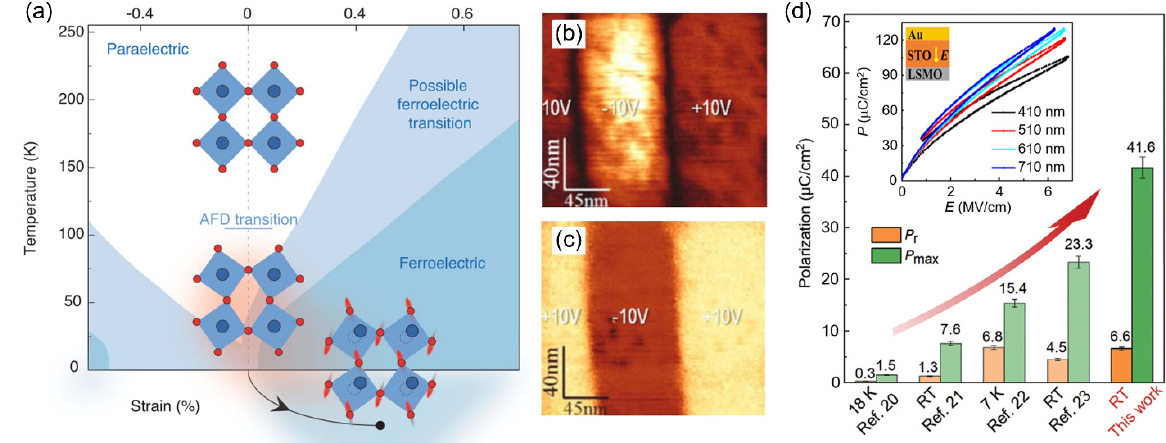
Figure 4. Structural phase transition and FE properties of SrTiO 3 . ( a ) Temperature–strain phase diagram showing an AFD transition and a further FE transition [102]. ( b,c ) Piezoresponse force microscopy (PFM) amplitude and phase images of strain-free SrTiO 3 films recorded at 50 K at biasing voltages of ± 10 V [29]. ( d ) Comparisons of P r and maximum polarization ( P max ) between Ti/O-deficient SrTiO 3 ( P r = 6.6 μ C/cm 2 , P max = 41.6 μ C/cm 2 ) and the literature cited therein [30]. The inset shows the P-E loops measured from the Au/SrTiO 3 /LSMO (x ≈ 1/3) capacitors [28].